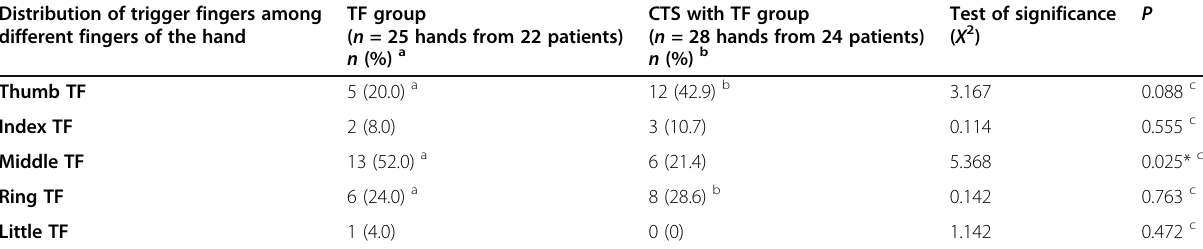
1 (4.0) TF , trigger finger; CTS , carpal tunnel syndrome, n (%), number (percentage) of hands; X 2 , value of Pearson ’ s chi-squared test. * P is significant at <